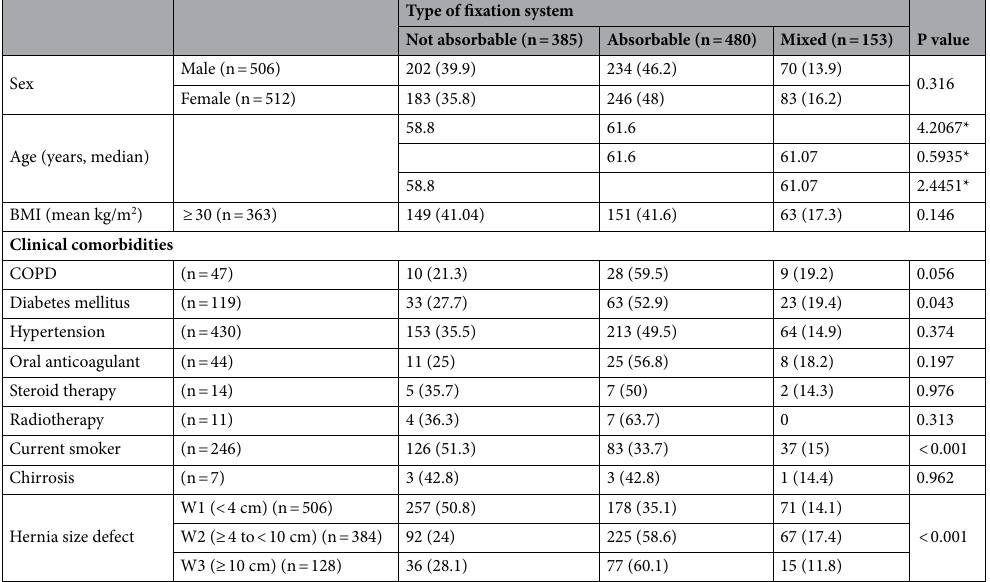
Table 6. Patient baseline demographic, clinical and hernia sizes according to the type of fixation system. Data presented were n (%), unless specified. BMI , body mass index; COPD , chronic obstructive pulmonary disease. *Tukey–Kramer pairwise comparisons for variable fixation studentized range critical value (.05, 3, 1007) = 3.3194419.